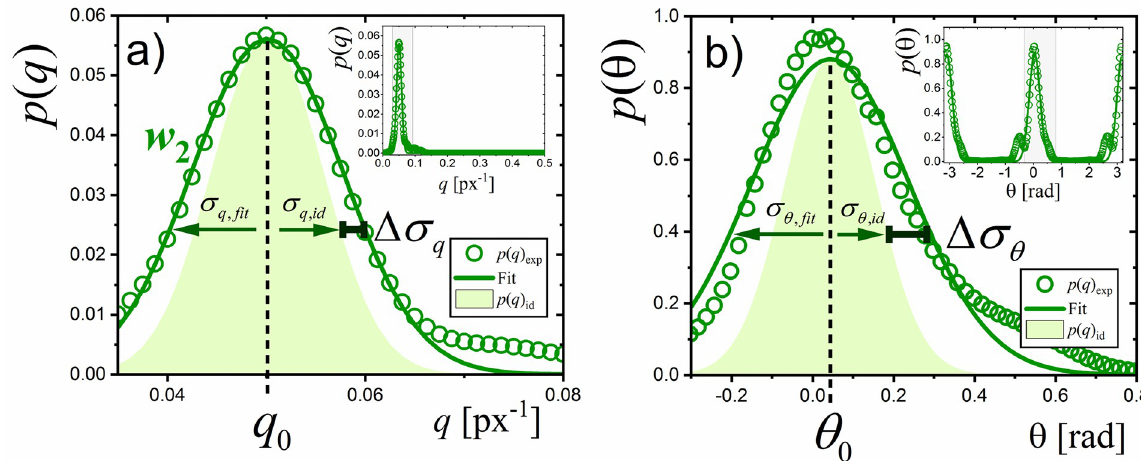
Fig 4. Derivation of morphometric parameters ( q 0 , σ q , θ 0 , σ θ ) by the analysis of local probability distributions for a single window position (window w 2 from Fig 3). Panel a) shows the p ( q ) distribution indicating a probability of finding a gland structure with a given spatial frequency, q . Open circles are experimental data. Solid line is the fitting result with normal distribution providing the values of maximum, q 0 , and the variance, σ q , fit . The maximum of the distributions is a measure of the local gland frequency, q 0 . Shaded area shows the ideal distribution with a variance, σ , expected for a constant frequency gland pattern limited by a Gaussian window. Broadening of the experimental distribution with q , id respect to the ideal one, Δ σ q , normalized to the σ q , id , is a measure of true gland frequency variance, σ q . The inset in (a) shows the p ( q ) in the whole range of q values. Panel b) shows the p ( θ ) distribution indicating a probability of finding a gland pattern with a given orientation, θ . Open circles are experimental data. Solid line is the fitting result with von Mises distribution providing the values of maximum, θ 0 , and the variance, σ θ , fit . The maximum of the distributions is a measure of the local gland orientation, θ 0 . The shaded area shows the ideal distribution with a variance, σ θ , id , expected for a constant frequency gland structure limited by a Gaussian window. Broadening of the experimental distribution with respect to the ideal one, Δ σ θ , normalized to the σ q , id , is a measure of true gland frequency variance, σ θ . The inset in (b) shows the p ( θ ) in whole range of θ